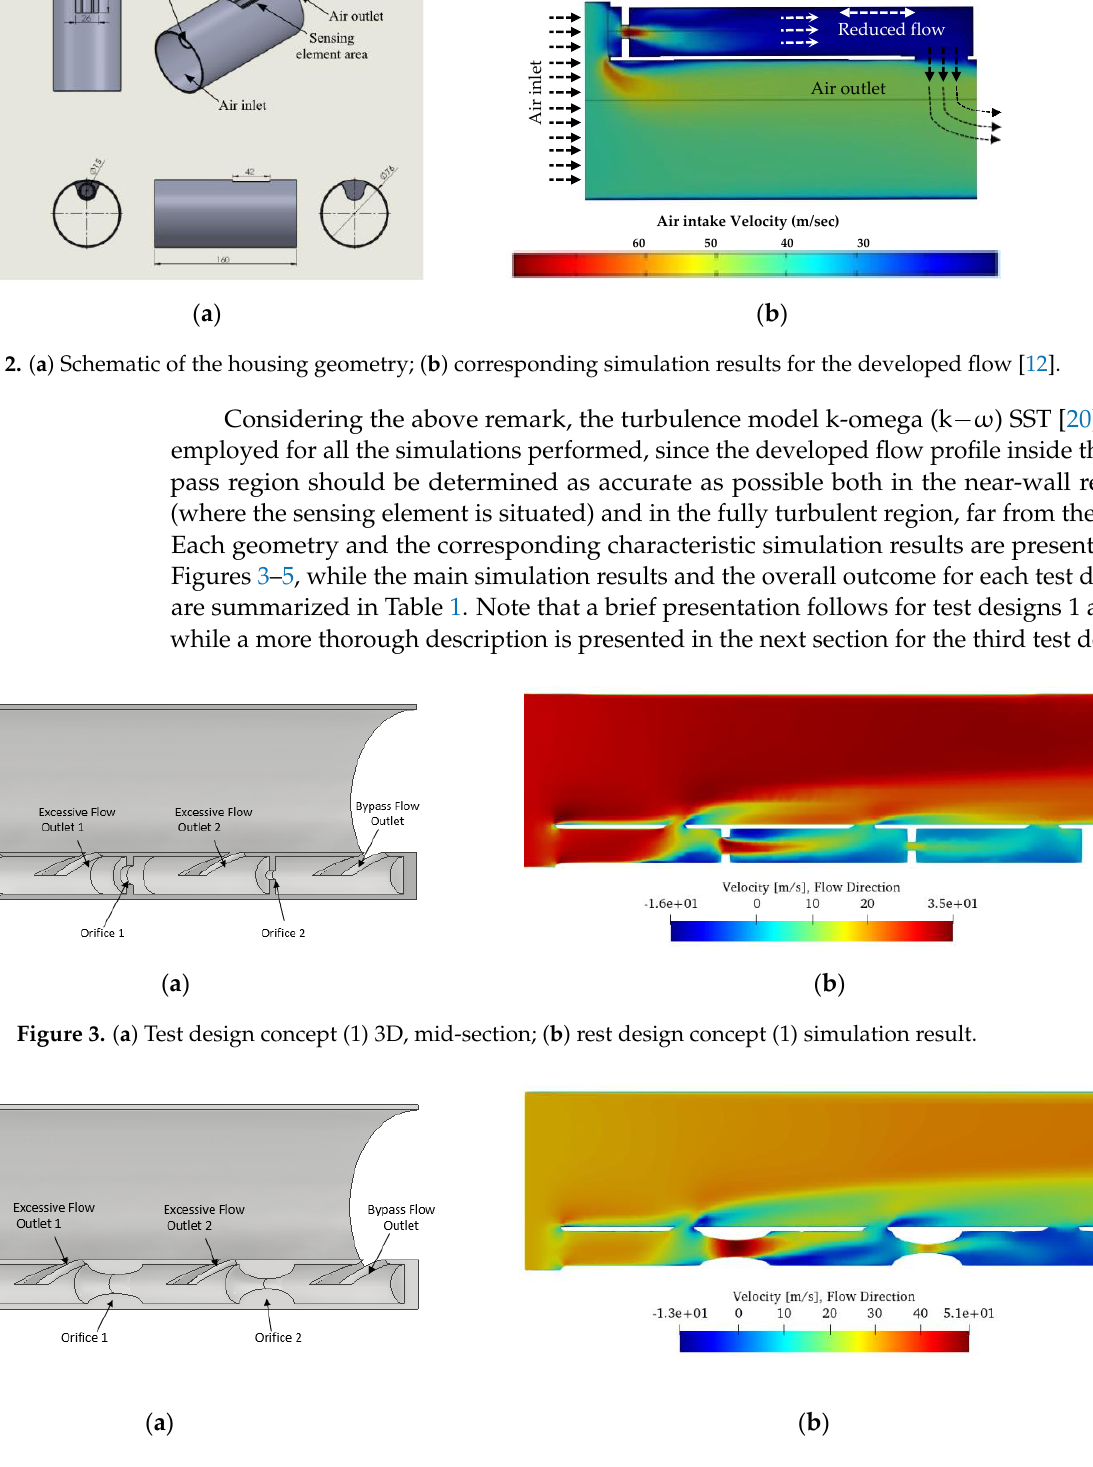
( b ) Figure 5. ( a ) Test design concept (3) 3D, mid-section; ( b ) test design concept (3) simulation result. Table 1. Test design concepts. Design